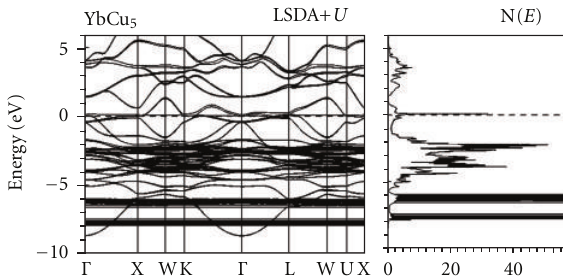
Figure 101: LSDA+ U self-consistent fully relativistic, spin-polar- ized energy band structure and total DOS (in states/(unit cell eV)) of YbCu 5 ( U e ff = 6eV) [475].